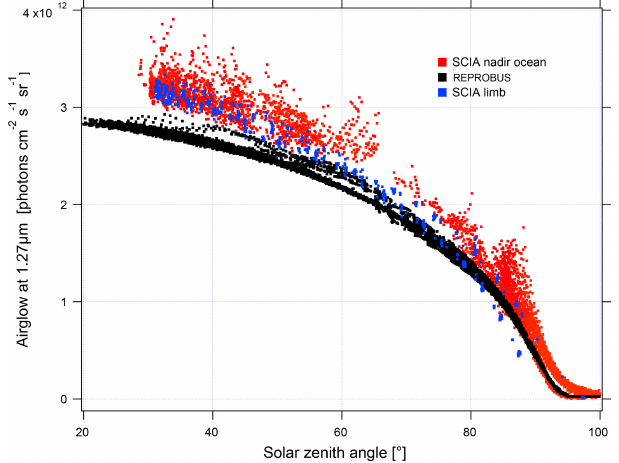
Figure 18. Airglow intensity at nadir according to the SZA for the month of April 2007: in red are SCIAMACHY measurements at nadir with a reflected solar spectral radi- ance < 5Wm − 2 sr − 1 µm − 1 ; in blue are nadir intensities retrieved from SCIAMACHY measurements at the limb; in black are simula- tions with REPROBUS v02. The airglow intensity at its maximum reaches 3 . 2 × 10 12 photonscm − 2 s − 1 sr − 1 , which corresponds to 5mWm − 2 sr − 1 (spread over a few nanometres’ wavelength), to be compared to a solar backscattered luminance (radiance) of ∼ 5 to 70Wm − 2 sr − 1 µm − 1 (see Fig. 16).